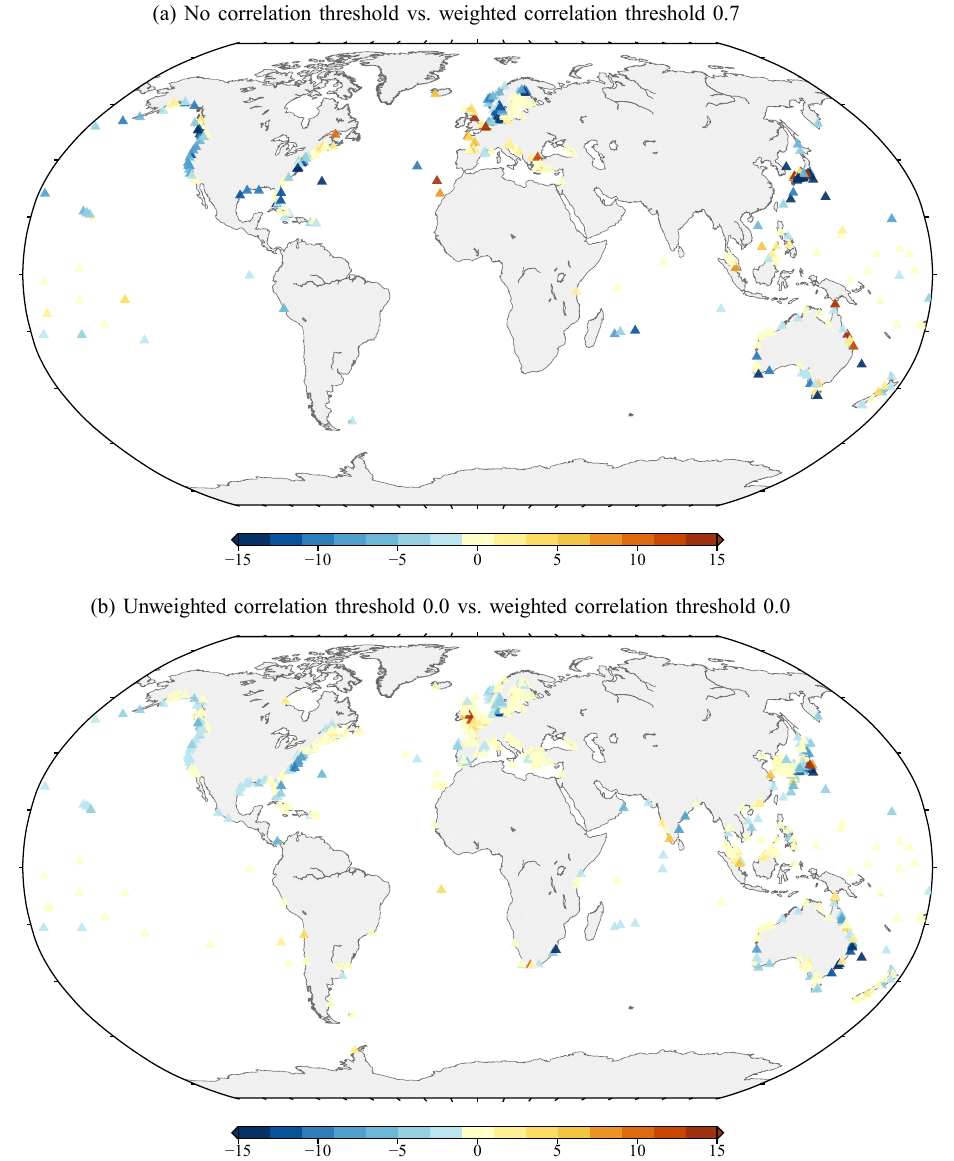
Figure 4. Change in SD (mm) of the differenced time series using correlation thresholds and weighting. Note that a correlation threshold of 0.0 indicates positive correlations